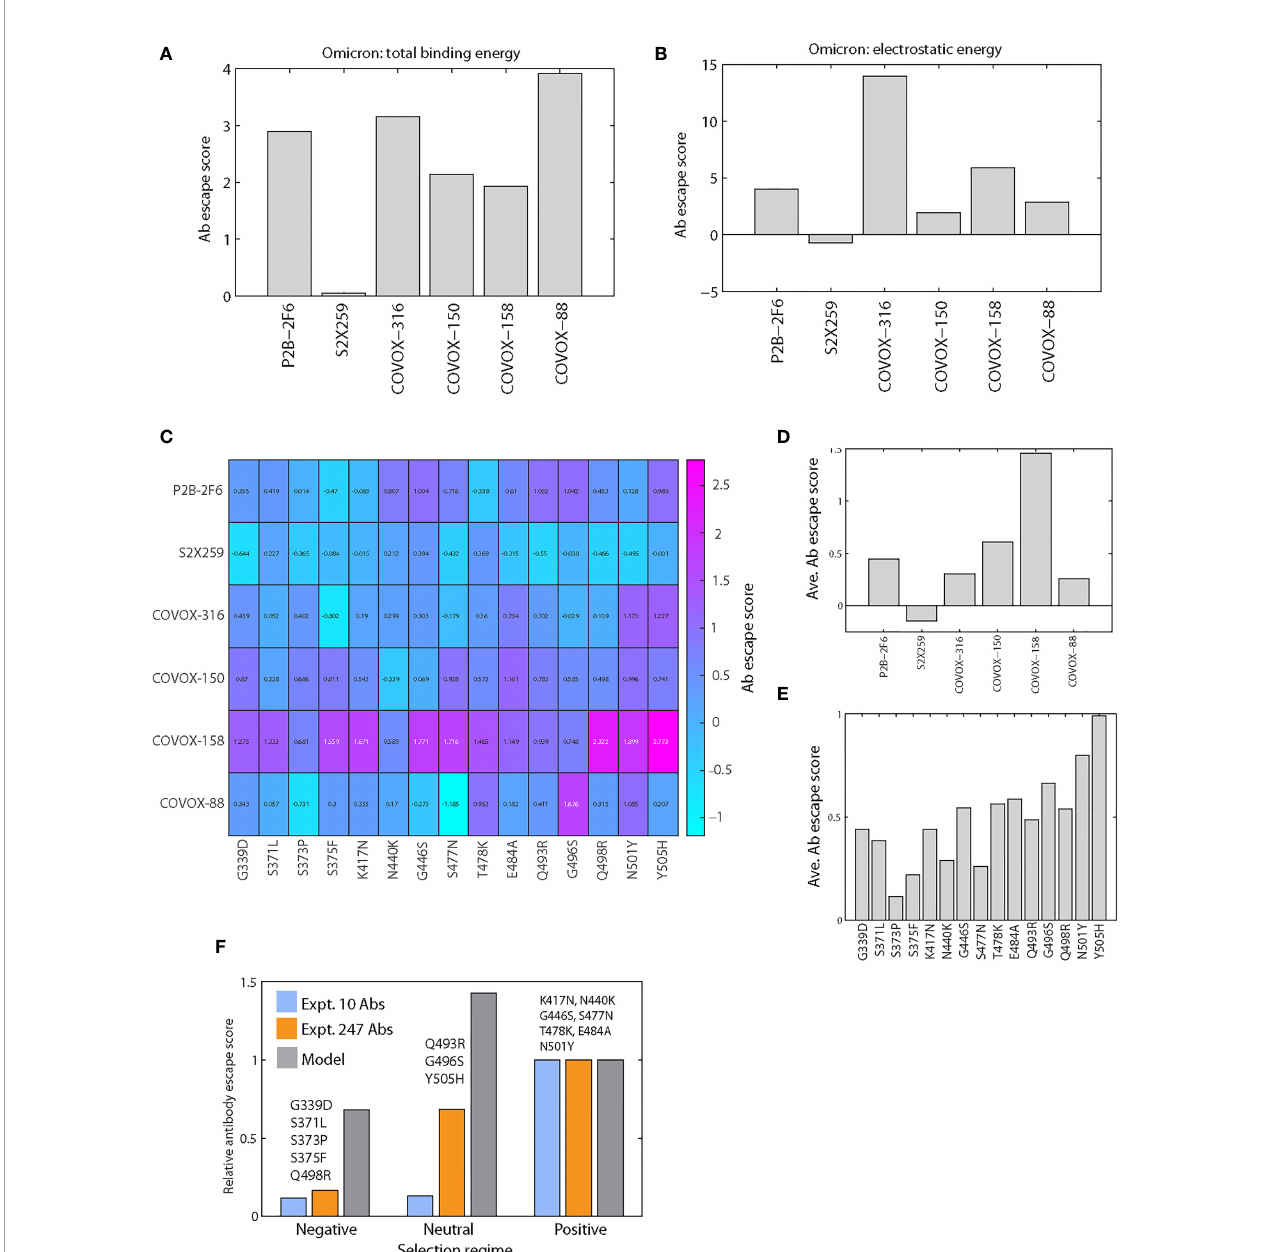
FIGURE 5 | Antibody escape scores of Omicron S RBD mutations. (A) Antibody escape scores of six antibody-Omicron S RBD complexes. (B) Electrostatic component of antibody escape scores of six antibody-Omicron S RBD complexes. (C) Antibody escape score matrix of six antibodies against 15 individual Omicron mutations. (D) Average antibody escape scores of six antibodies induced by individual Omicron mutations (derived from C ). (E) Antibody escape scores of individual Omicron mutations averaged over six antibodies. (F) Comparison of model and experimental relative antibody escape scores of Omicron S RBD mutations grouped by selection regime. To enable a comparison of predicted and experimental scores, the group escape scores were normalized by the score of the positive group to yield relative escape scores. Two separate experimental datasets were used for comparison: one generated using 10 antibodies and another using 247